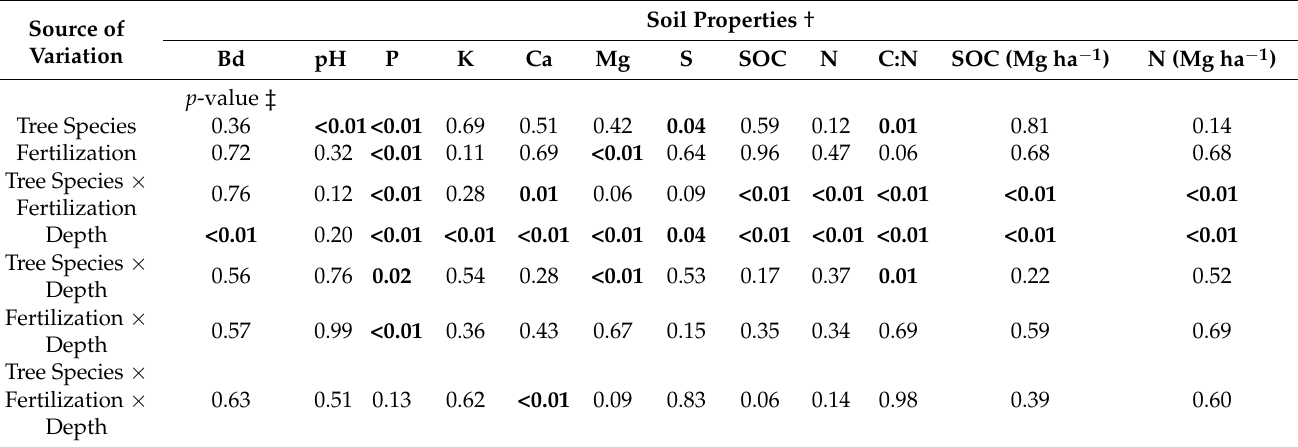
Table 2. Summary of analysis of variance of soil properties by tree species, fertilization treatments, soil depth, and their interactions in a 17-year agroforestry site in Fayetteville, AR, in terminal (2016) soil